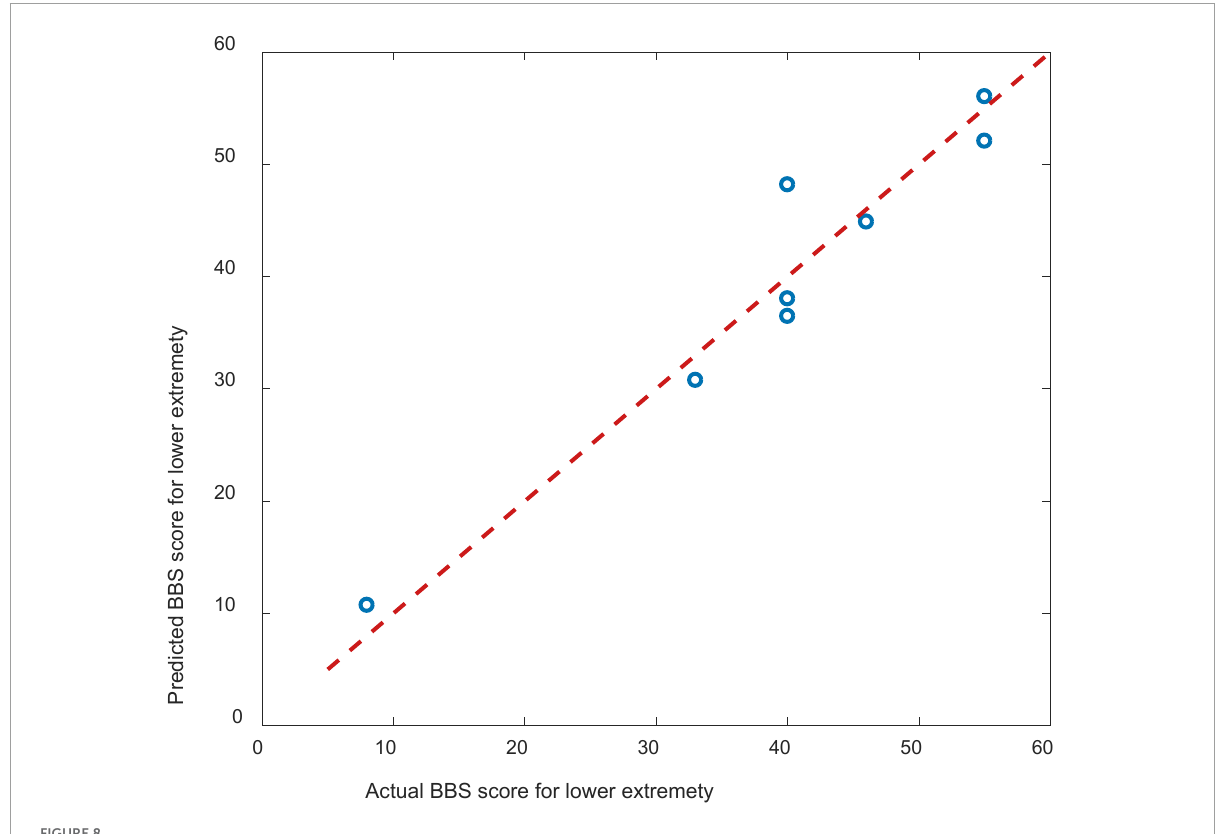
FIGURE8 Scatterplots showing the relations between the actual and predicted BBS scales.